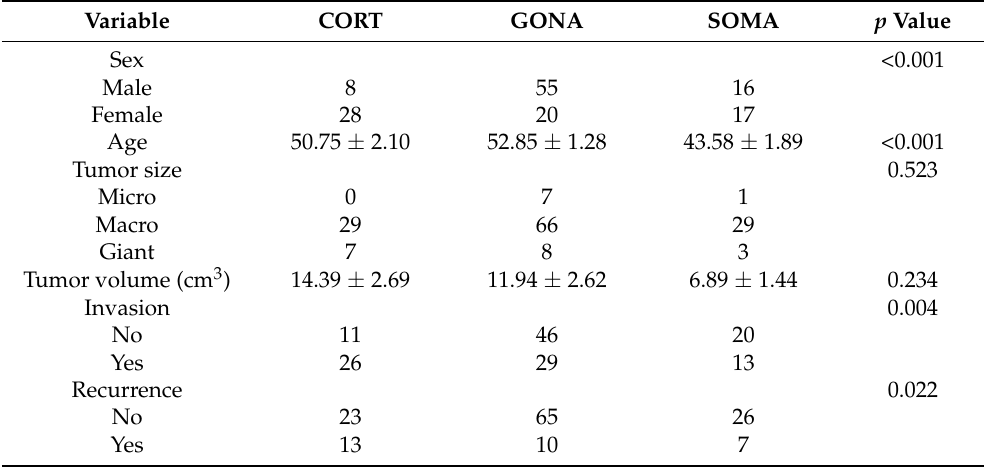
Table 1. Clinicopathological features of patients with pituitary